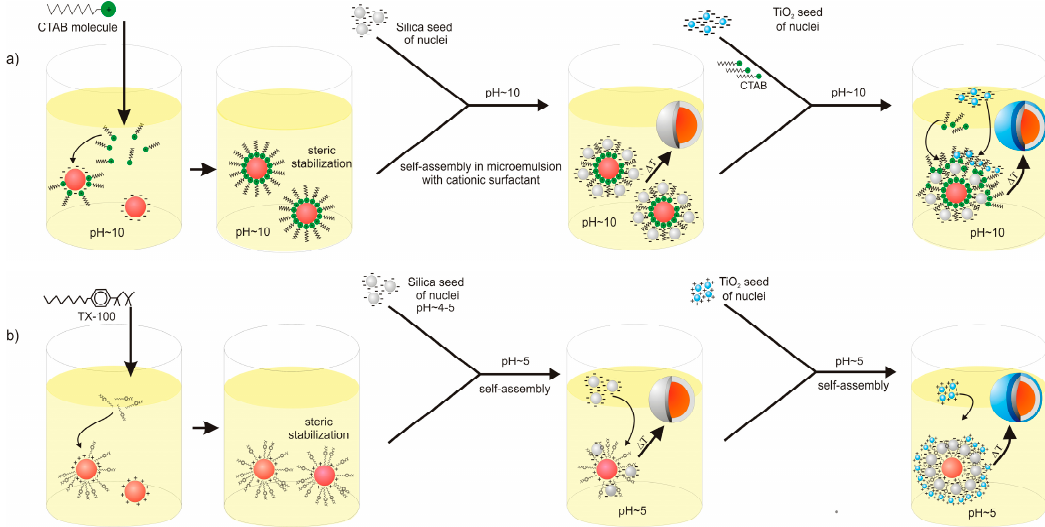
Figure 12. Schematic illustration of magnetic photocatalysts preparation procedure at pH 10 ( a ) and at pH 5 ( b ) in w/o microemulsion.